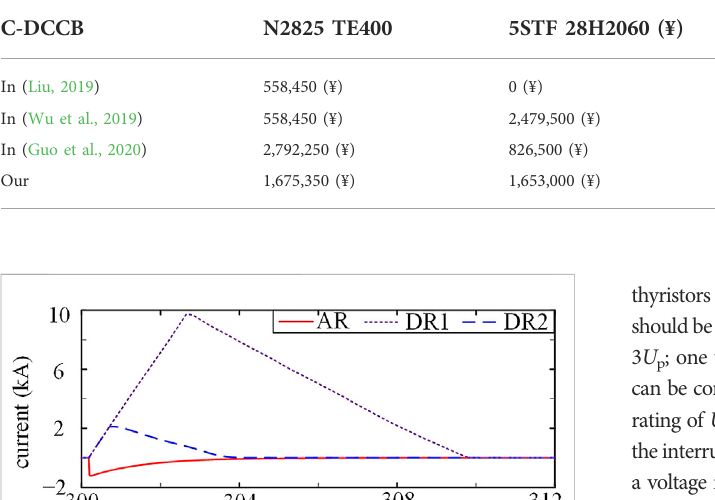
TABLE 3 Semiconductor costs of C-DCCBs.